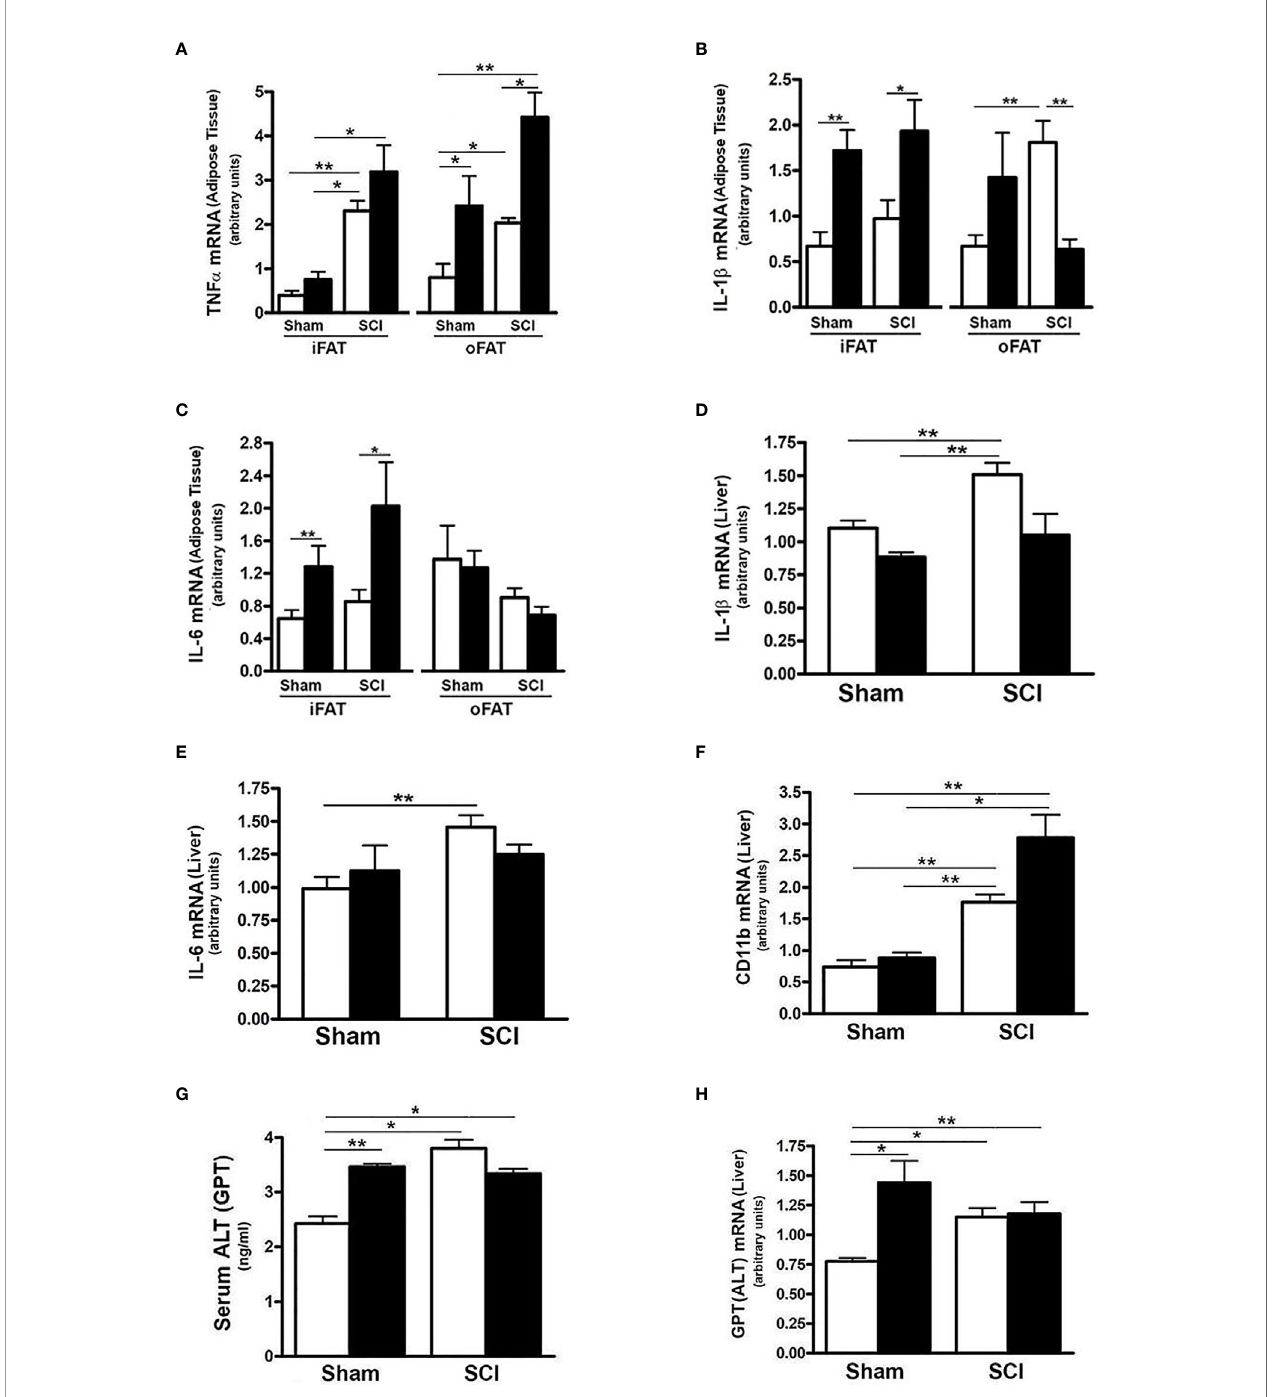
FIGURE 6 | SCI Caused Hepatic Pro-In fl ammatory State and Liver Toxicity. Mice were fed with either ConD (White Bar) or HFD (Black Bar) after surgery. (A) , total RNA was isolated from mouse adipose tissues and subjected to Rt-PCR for TNF a mRNA expression; (B) , IL-1 b mRNA in adipose tissue; (C) , IL-6 mRNA expression in adipose tissue; (D) , total RNA was isolated from mouse liver and subjected to Rt-PCR for IL-1 b mRNA; (E) , hepatic IL-6 mRNA; (F) , hepatic CD11b mRNA expression; (G) , Mouse serum was collected and subjected to ELISA for ALT serum level; (H) , total RNA was isolated from mouse liver and subjected to Rt-PCR for hepatic ALT mRNA expression. Data shown are means values ± SEM (n = 5). * p < 0.05; ** p <